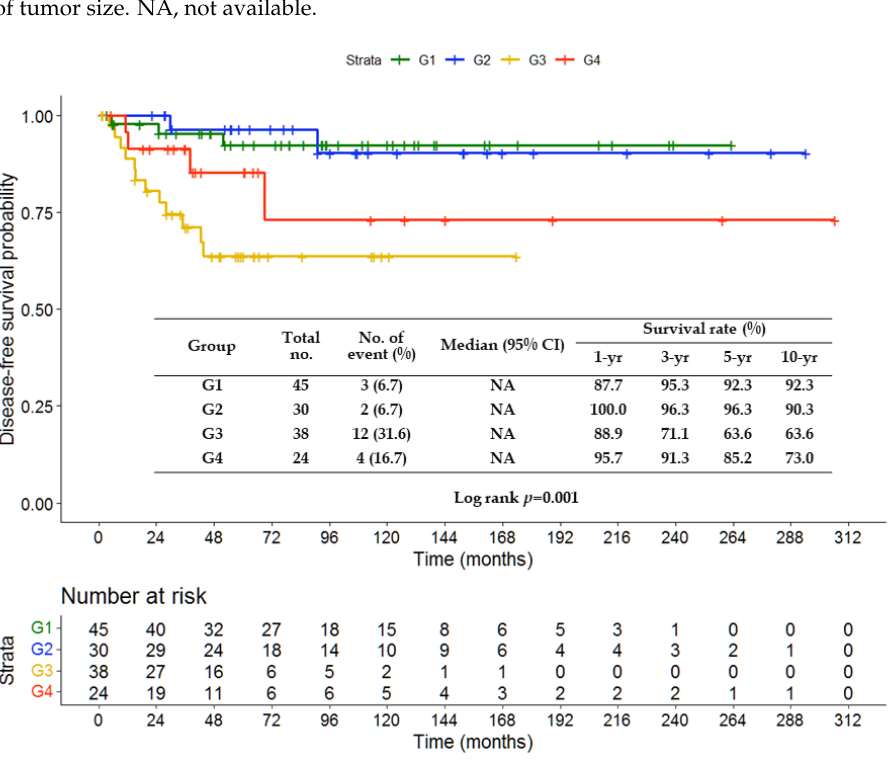
Figure 3. Kaplan–Meier curves of disease-free survival ( A ) and cancer-specific survival ( B ) in terms of tumor size. NA, not available.